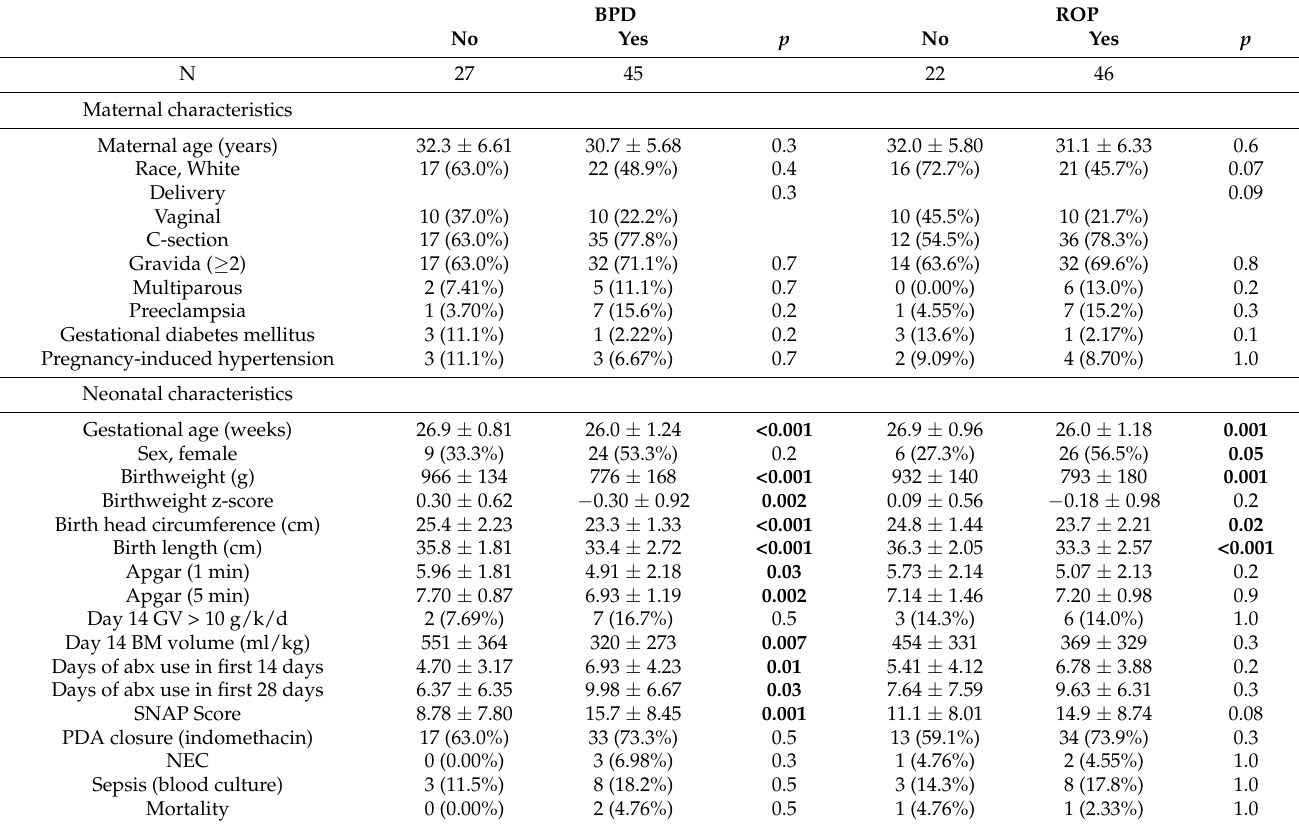
Table 2. Maternal and neonatal characteristics of the study cohort according to neonatal disease outcomes 1 .